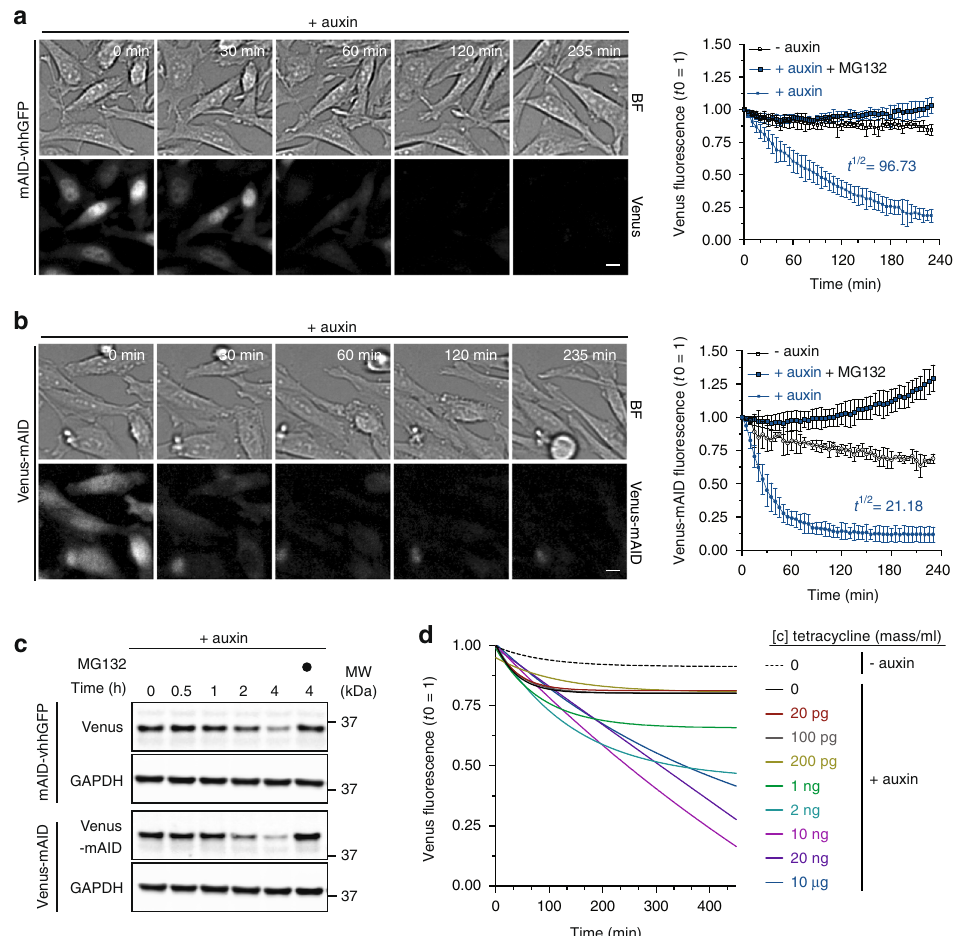
Fig. 2 Kinetics of Venus degradation by mAID-nanobodies. a Time-lapse images and degradation kinetics of Venus targeted by the mAID-nanobody or b of Venus-AID after the addition of 0.5 mM auxin. Scale bar: 10 μ m. Quanti fi cations show the mean ± s.d. ( n = 5, -auxin, + auxin + MG132; n = 10, + auxin). c Western blot analyses of cells treated as in a and b for the indicated time with 0.5 mM auxin or auxin together with 10 μ M proteasome inhibitor MG132. d Titration of tetracycline-inducible expression of mAID-nanobodies and the effect on the degradation kinetics of Venus in the presence of 0.5 mM auxin. Note, the 100 pg curve is masked by the 20 and 0 pg curves. Quanti fi cations show non-linear fi t (one-phase decay) of ( n = 6, 0 tetracyline ± auxin; n = 3, remaining concentrations). Note, images of – auxin, + auxin and 10 μ M MG132-treated cells, degradation of Venus by deGradFP, and Western blot detection of mAID-nanobody expression during the titration are shown in Supplementary Figure